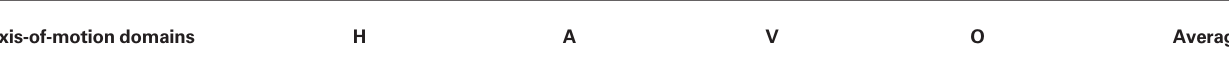
Table 1 | Size comparison of orientation (axis of motion) domains and direction domains. Axis-of-motion domains H A V O Average Measurements of domains elicited by bidirectional drifting gratings. Measurements were taken from thresholded images of the ROI. Values for horizontal (H), acute (A), vertical (V) and oblique (O) axis-of-motion domains are averages of values from three cases. The column “average” is the average of H, A, V and O